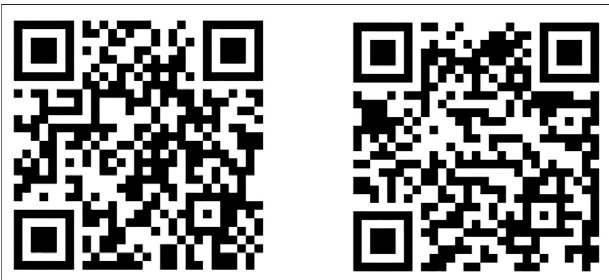
FIGURE 5 | QR code to view videos related to the MAR (virtual tour): challenge 1 (left) and challenge 6 (right).